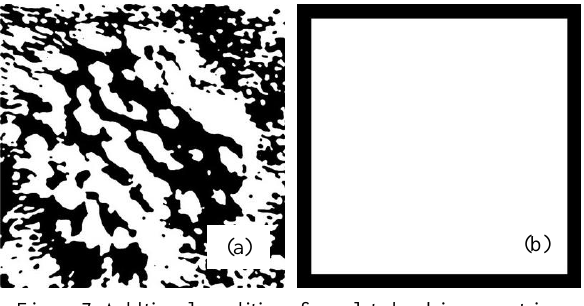
Figure 7. Addtional conditions formulated as binary matrices